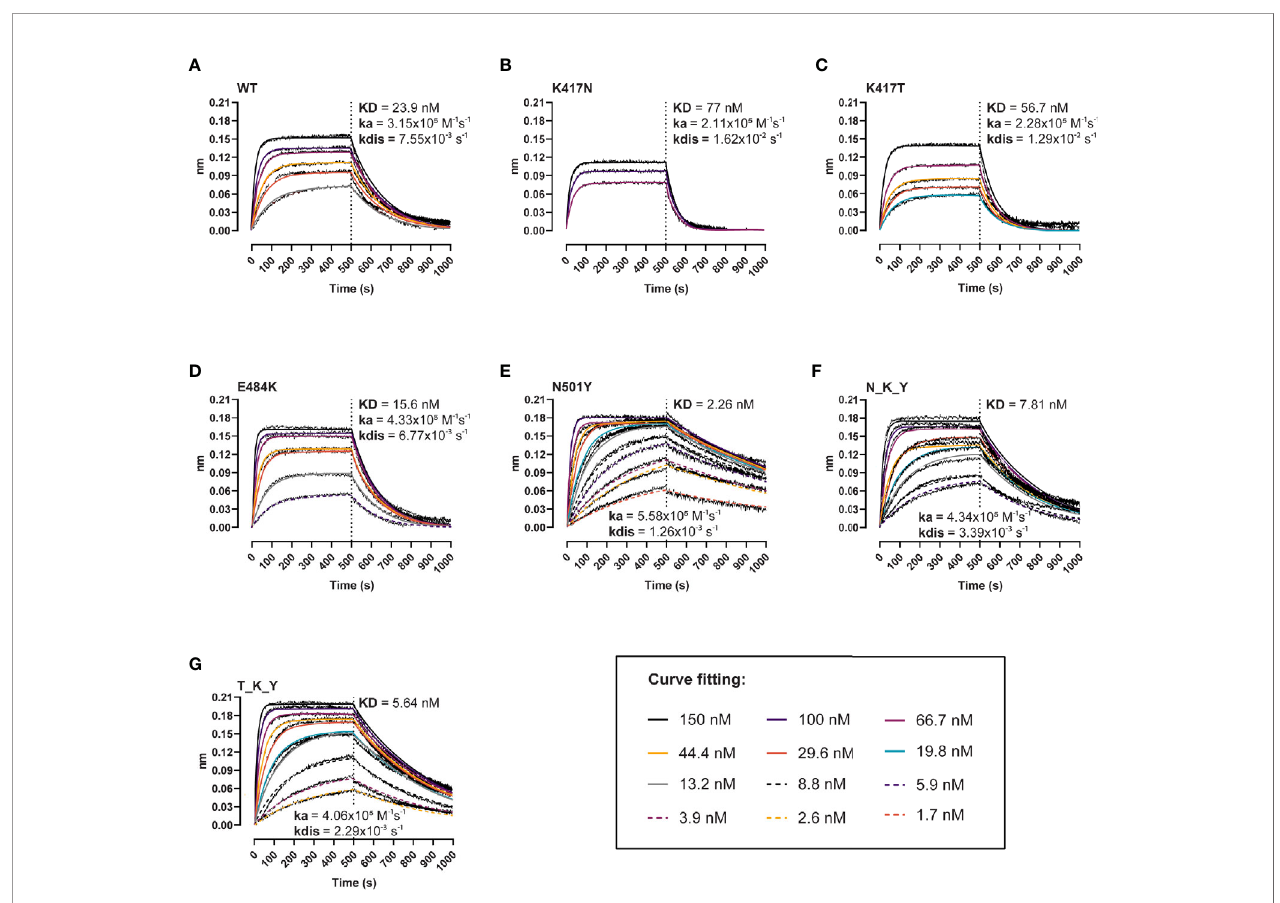
FIGURE 2 | Binding kinetics of the interaction between human ACE-2 and the RBD variants. BLI binding response curves of RBD wt (A) , K417N (B) , K417T (C) , E484K (D) , N501Y (E) , B.1.351 (N_K_Y) (F) , and P.1 (T_K_Y) (G) to ACE-2-Fc immobilized unto AHC sensors. ACE-2-coated sensors were dipped into 12-point dilution series of RBD starting at 150 nM for 500 s, followed by a dissociation phase for 500 s. Colored lines represent global fi ts using a 1:1 binding